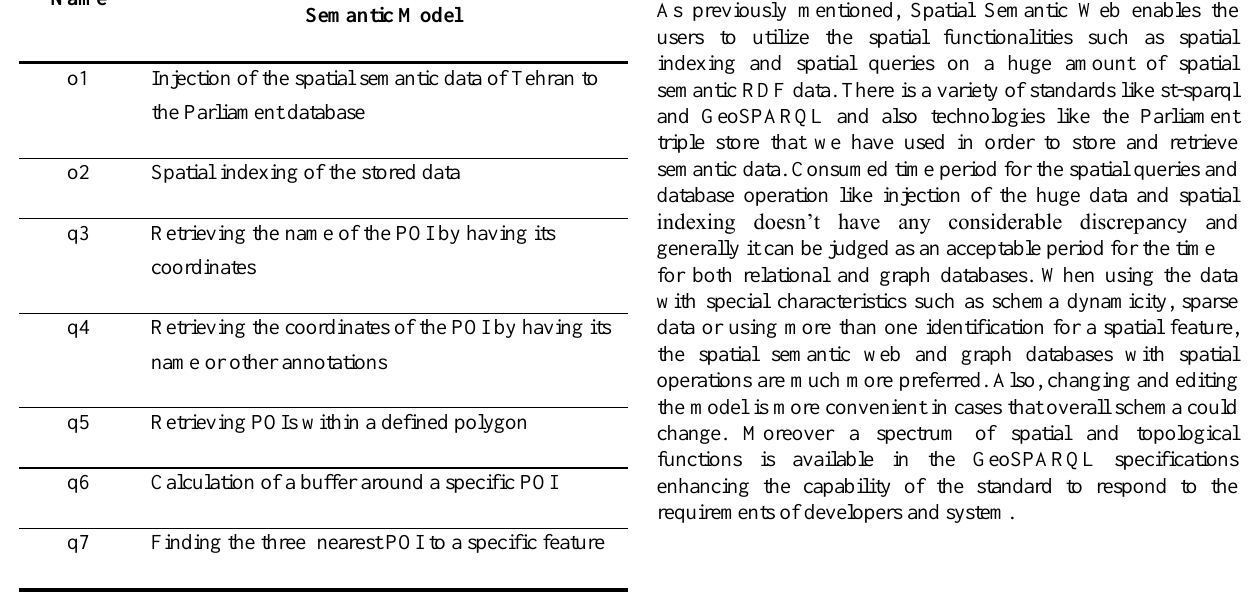
Table 1. Spatial semantic operation and Queries Query or Operation Performed On the Spatial